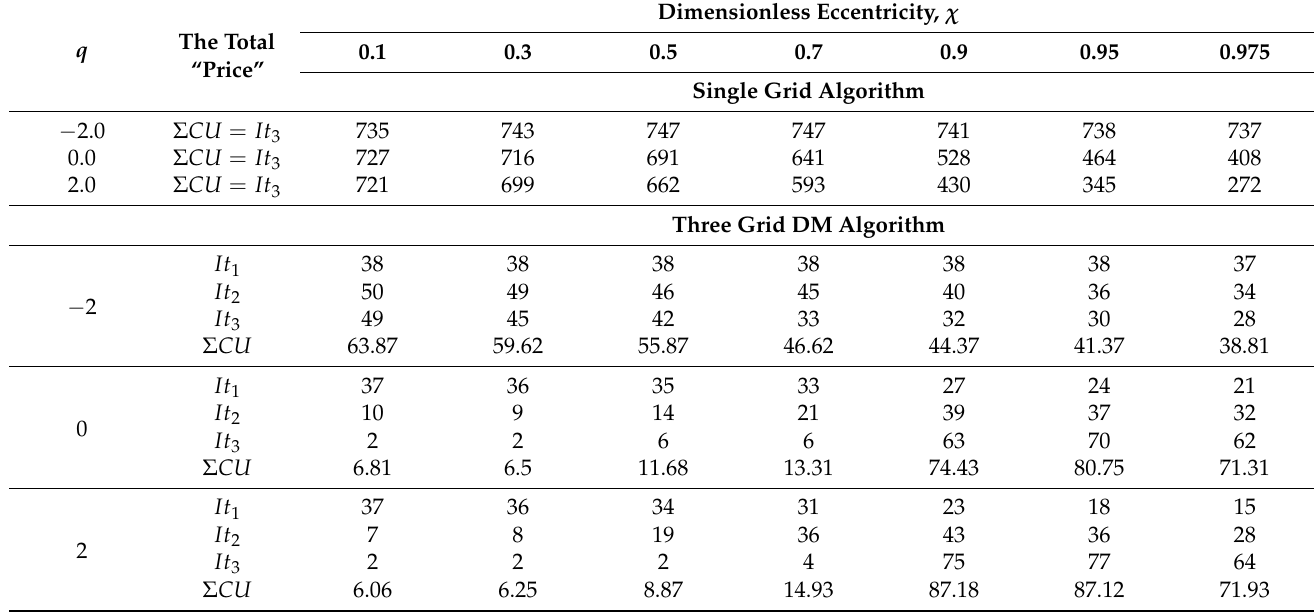
Table 1. Comparison of the efficiency of algorithms for solving the Reynolds